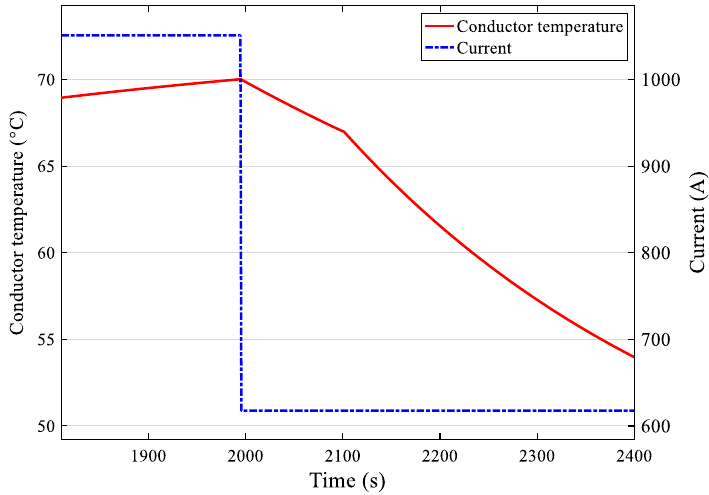
Figure 13. Change of conductor temperature after load shedding.